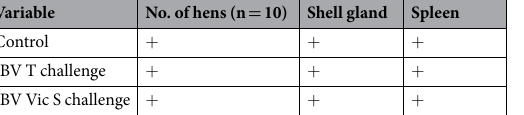
Table 2. Grouping of laying hens for tissues collection for reference genes study. The control group was the same for both the IBV T and Vic S strains challenge